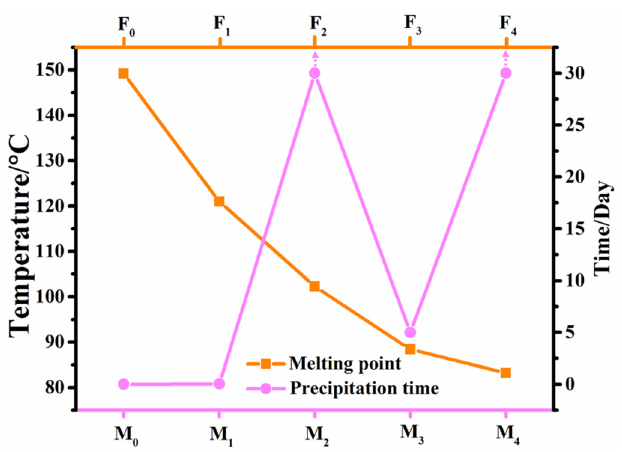
Figure 1. Melting points of benzoxazole LCs and their precipitation times in the parent LC mixture. Table 1. Types of mesophases, transition temperatures and corresponding enthalpies obtained by POM and DSC methods for compounds F 0 – F 4